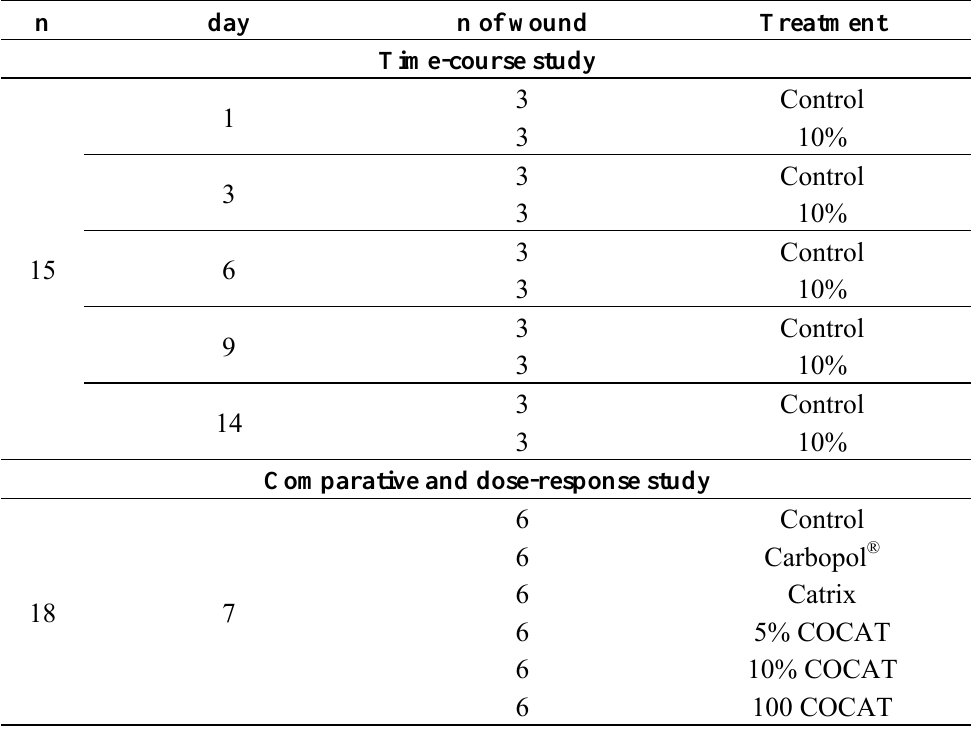
Table 2. Experimental Design, preliminary and main